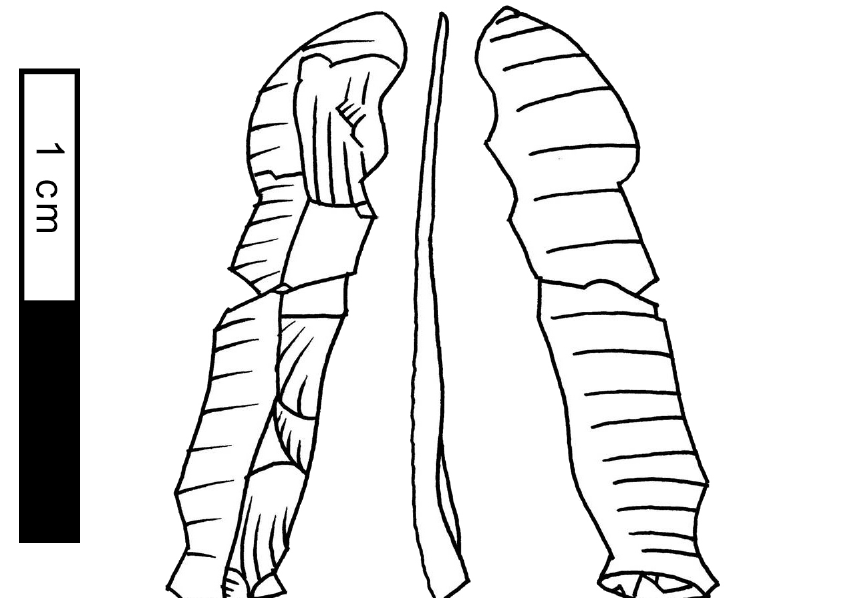
Figure 20. ‘Long flake’ 5.19 v3 illustrating the asymmetry associated with bulb reduction flakes (drawing by the author).